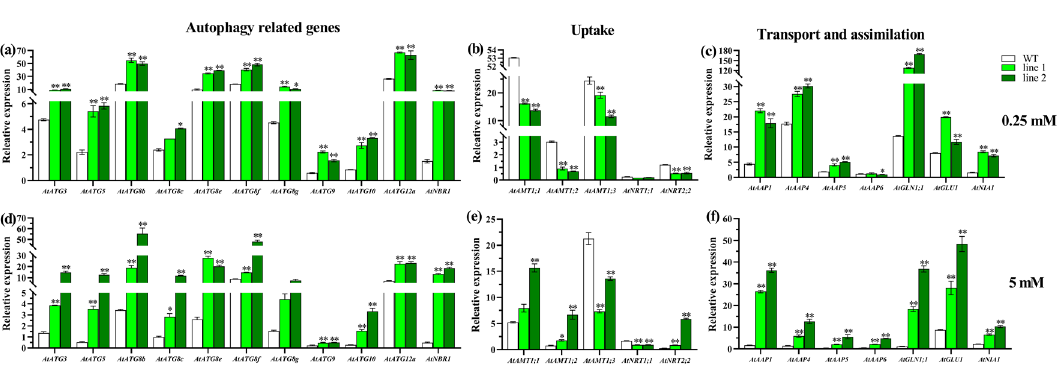
Figure 6. Gene expressions under deficient and su ffi cient N conditions. The expression of autophagy-related genes in leaves of overexpression Arabidopsis (OE) and wild-type (WT) plants under 0.25 mM ( a ) and 5 mM ( d ) N, respectively. The expression of the genes involved in N uptake in roots of OE and WT plants under 0.25 mM ( b ) and 5 mM ( e ) N, respectively. The expression of the genes related to N transport and assimilation in leaves of OE and WT plants under 0.25 mM ( c ) and 5 mM ( f ) N, respectively. 0.25 mM N, 0.125 mM NH 4 NO 3 ; 5 mM N, 2.50 mM NH 4 NO 3 . Values are means ± standard (SD) ( n = 3). Asterisks indicate significant di ff erence between WT and two OE lines (line 1, line 2). * p < 0.05; ** p < 0.01 ( t -test). AAP , amino acid permease gene; AMT , ammonium transporter; NRT , nitrate transporter; NIA , nitrate reductase encoding gene; GLU , Gln 2-oxoglutarate aminotransferase encoding gene; GLN , Gln synthetase encoding gene.